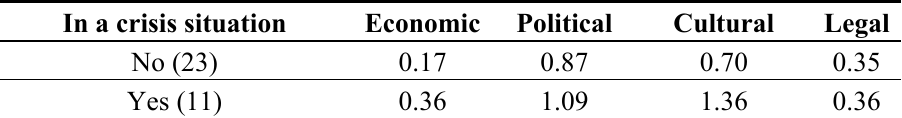
Table 6. External dimensions (crisis or not crisis) (average